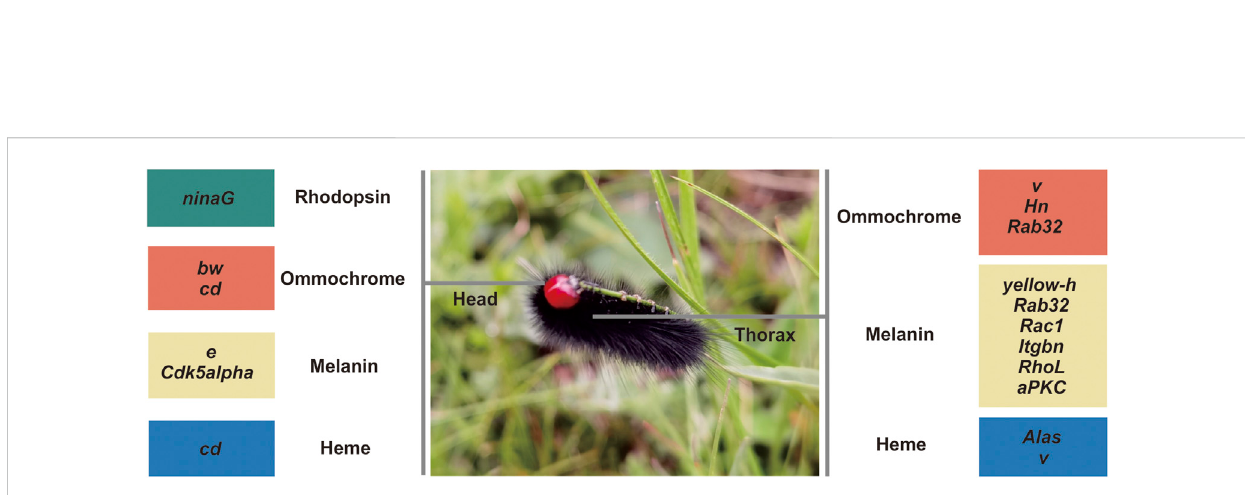
FIGURE 3 Signi fi cantly differentially expressed pigment pathway-associated genes between the head and thorax transcriptomes of Gynaephora aureata . Rhodopsin-associatedgenes,ommochrome-associated genes,melanin-associatedgenes,andheme-associatedgenesareshowningreen,red,yellow, and blue boxes, respectively. NinaG , bw , cd , e, and Cdk5alpha are signi fi cantly upregulated in the head relative to the thorax of G. aureata . V , Hn , Rab32 , yellow-h , Rac1 , Itgbn , RhoL , aPKC, and Alas are signi fi cantly upregulated in the thorax relative to the head of G. aureata